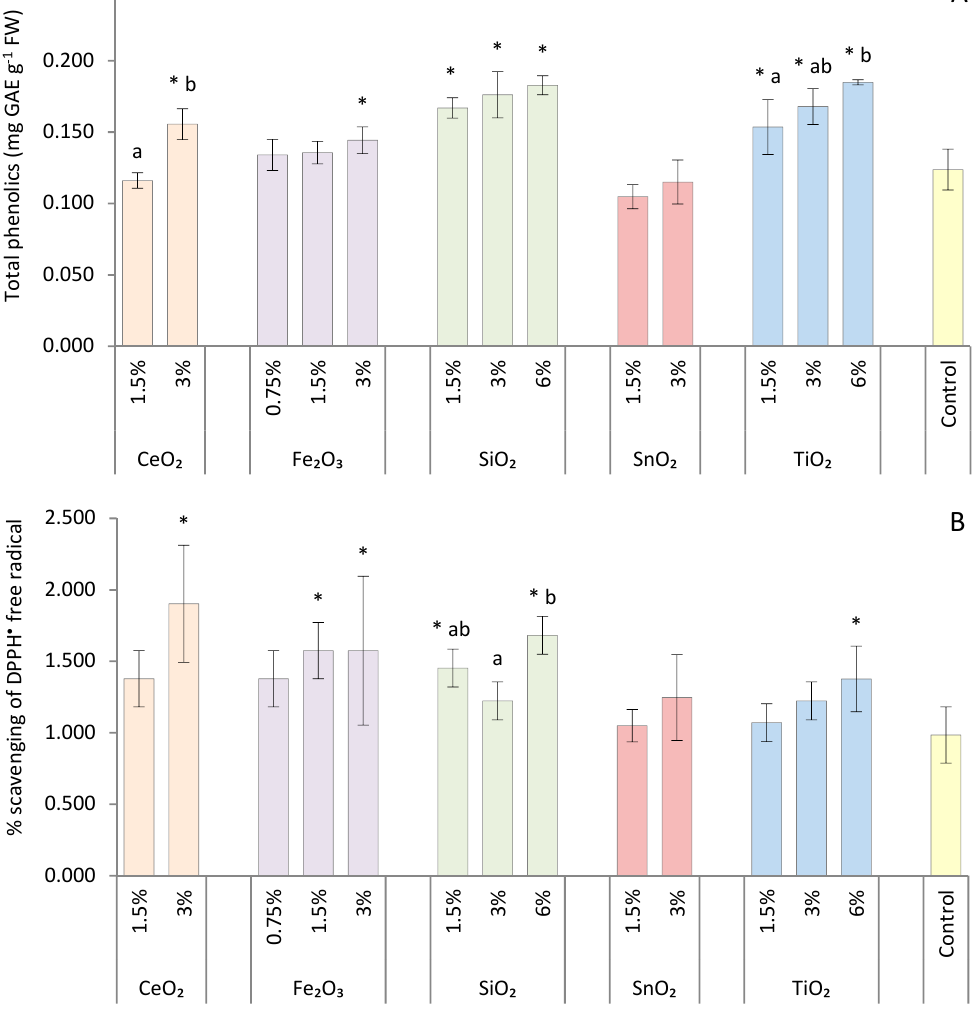
Figure 3. Total phenolic content (A) and total antioxidant capacity (B) of oakleaf lettuce seedlings treated with engineered nanoparticles (nano-metal/metalloid oxides; MO-NPs) applied to the leaves at different concentrations. Control plants were sprayed with deionized water. *Denotes significant differences between particular treatments and unexposed control, comparisons were performed by Fisher test ( p ≤ 0.05). Means ( n = 3) for concentrations of given MO-NPs followed by different letters are significantly different at p ≤ 0.05 according to Fisher test. Bars represent standard deviations (± SD).